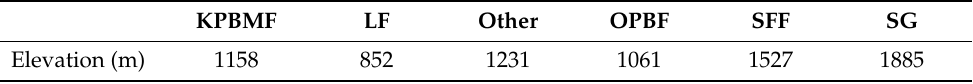
Figure 7. Box − and − whisker plot of Tree Species Elevation Distribution. Table 3. Average elevation of tree species in Changbai Mountain Protection Development Zone.